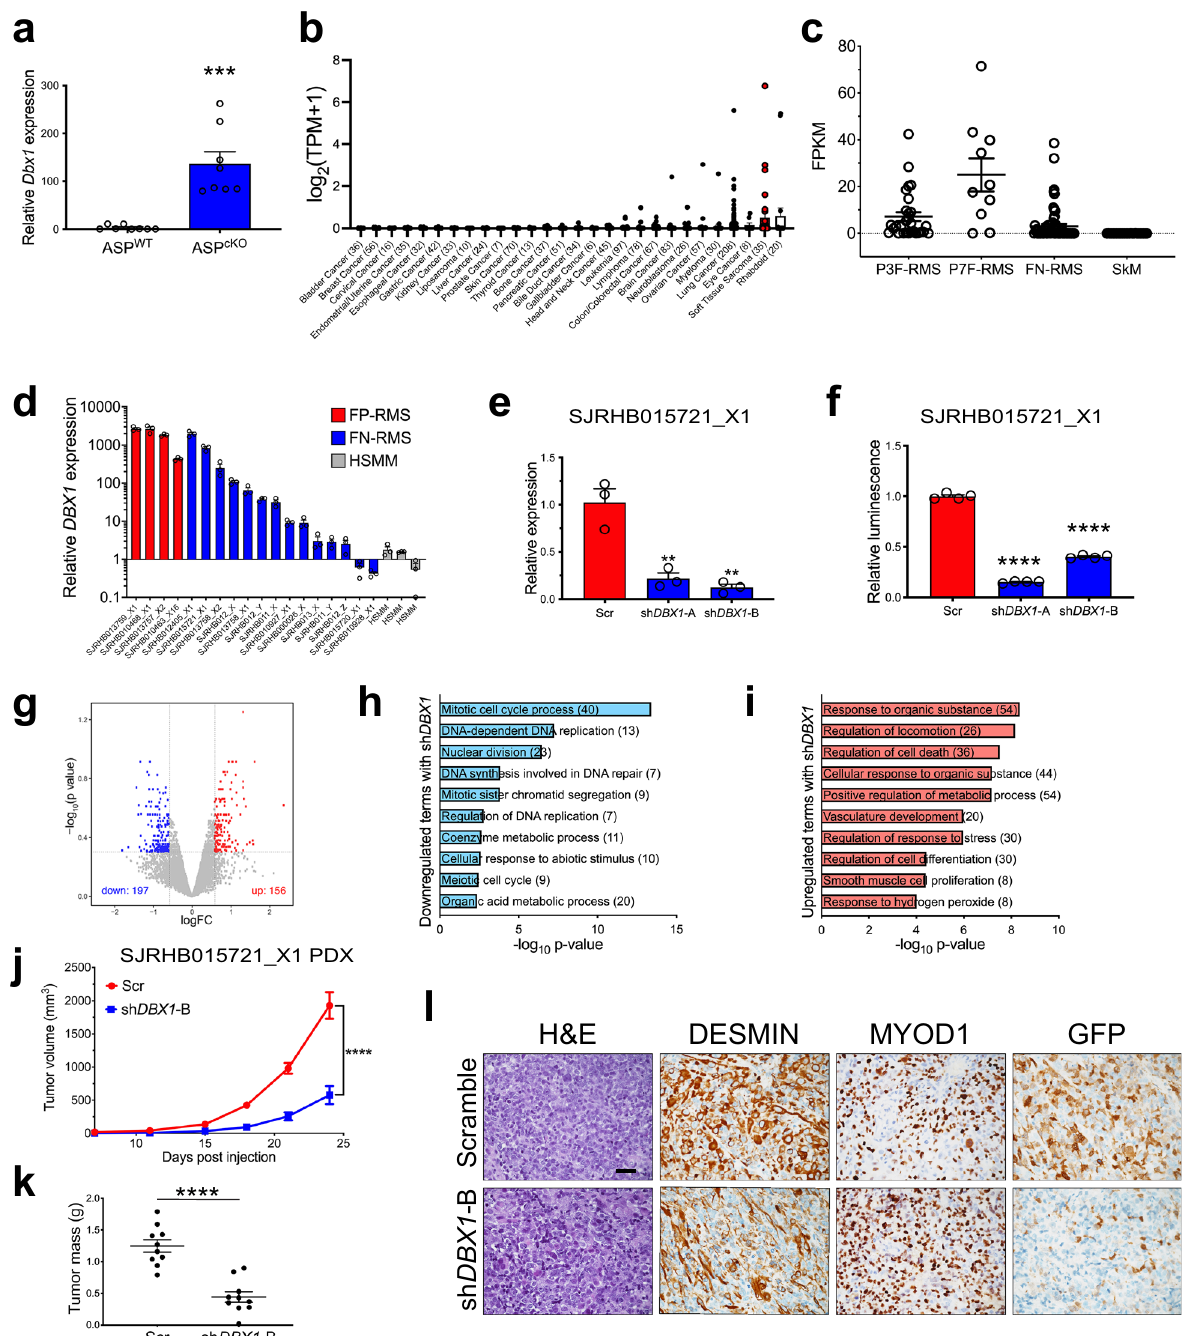
at 37 °C, the cells were either placed in spheroid culture or injected into the gastrocnemius muscle of SCID/Beige mice. PAX7 knockdown was con fi rmed in spheroid culture cells (Supplementary Fig. 7i). In both SJRHB015721_X1 and SJRHB012405_X1 PDXs, PAX7 knockdown with sh PAX7 resulted in decreased tumor volume (Fig. 6j and Supplementary Fig. 7j); however, tumor mass only decreased in SJRHB015721_X1 (Fig. 6k and Supplementary Fig. 7k). Tumors from SJRHB012405_X1 retained PAX7 expression at the end- point suggesting a negative selection for cells with PAX7 knockdown (Fig. 6l and Supplementary Fig. 7l). Together, our in vitro and in vivo data con fi rm PAX7 is a dependency in FN- RMS